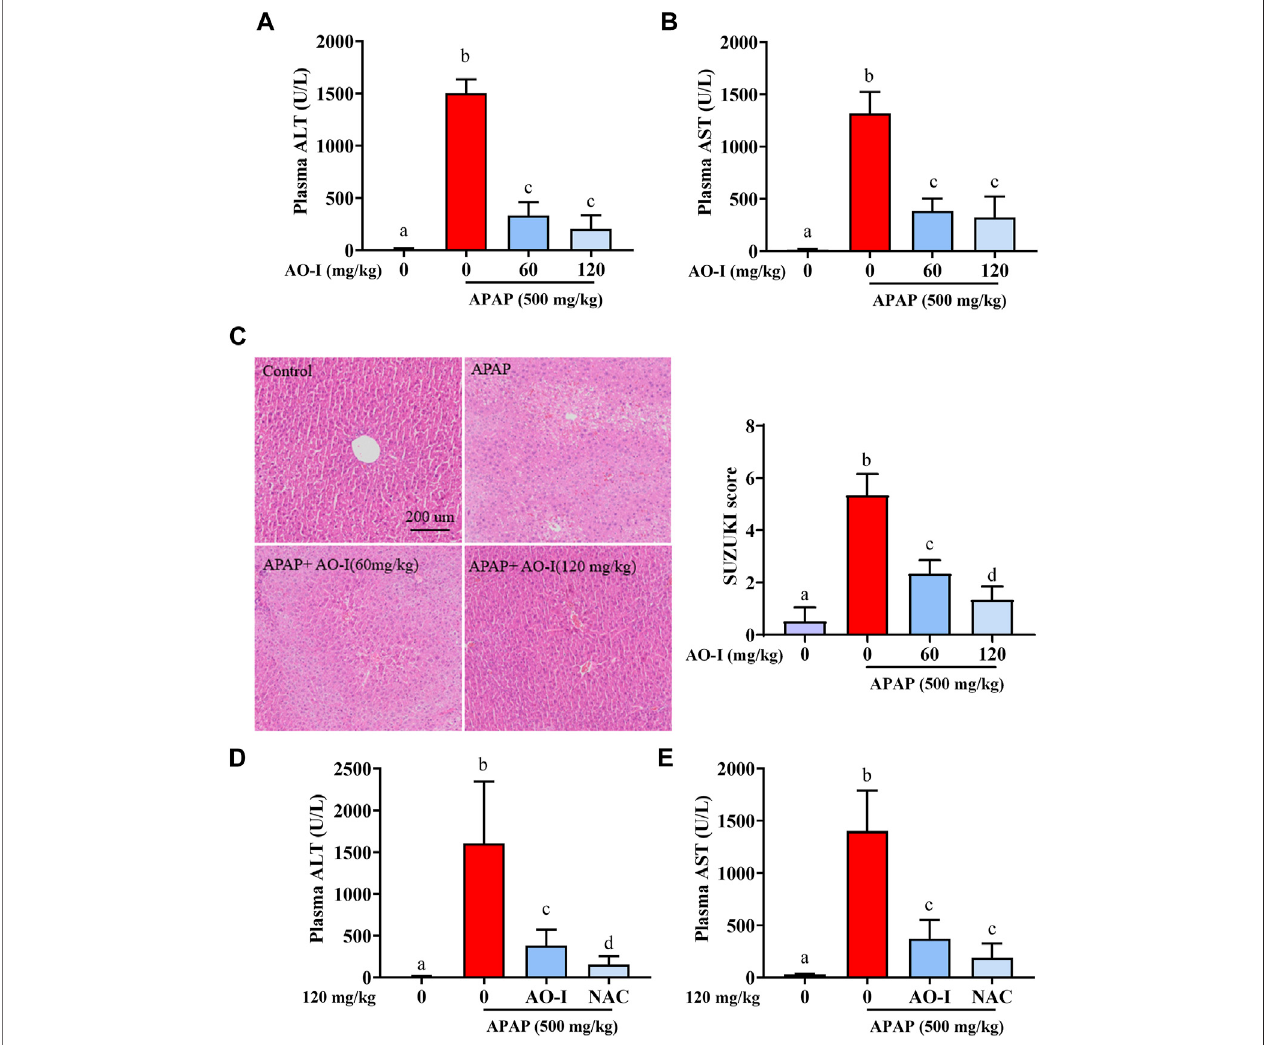
FIGURE 1 | AO-I protects against APAP-induced liver injury. Mice were given AO-I (60 and 120 mg/kg) or NAC (120 mg/kg) via intragastric administration 2 h before intraperitoneal APAP administration (500 mg/kg) ( n (cid:1) 4 – 6 in each group). (A,D) Plasma ALT level. (B,E) Plasma AST level. (C) Liver H&E staining (left panel) and Suzuki score (right panel). All data are presented as the mean ± SEM. Bars with different characters present statistically signi fi cant results, p <